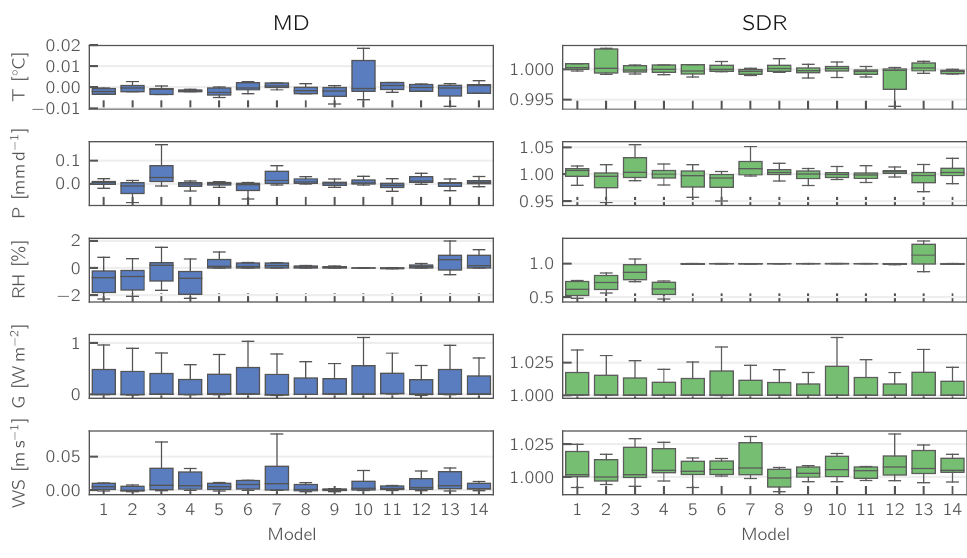
Figure 5. Mean deviation (MD) and standard deviation ratio (SDR) of simulated (i.e., downscaled and bias-corrected RCM data) vs. observed meteorological data for the historical period 1971–2005. The individual boxes represent the downscaled station meteorology for a given GCM–RCM combination (model IDs correspond to the ones in Table 2). Units given for the different variables apply only to MD (SDR is